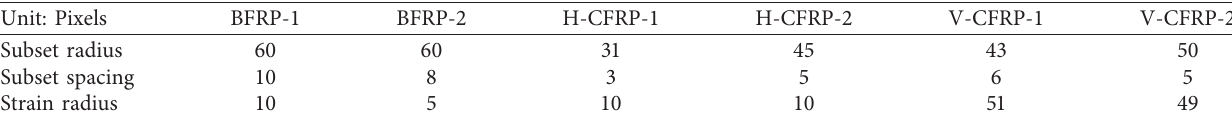
Table 2: Values of subset radius, subset spacing and strain